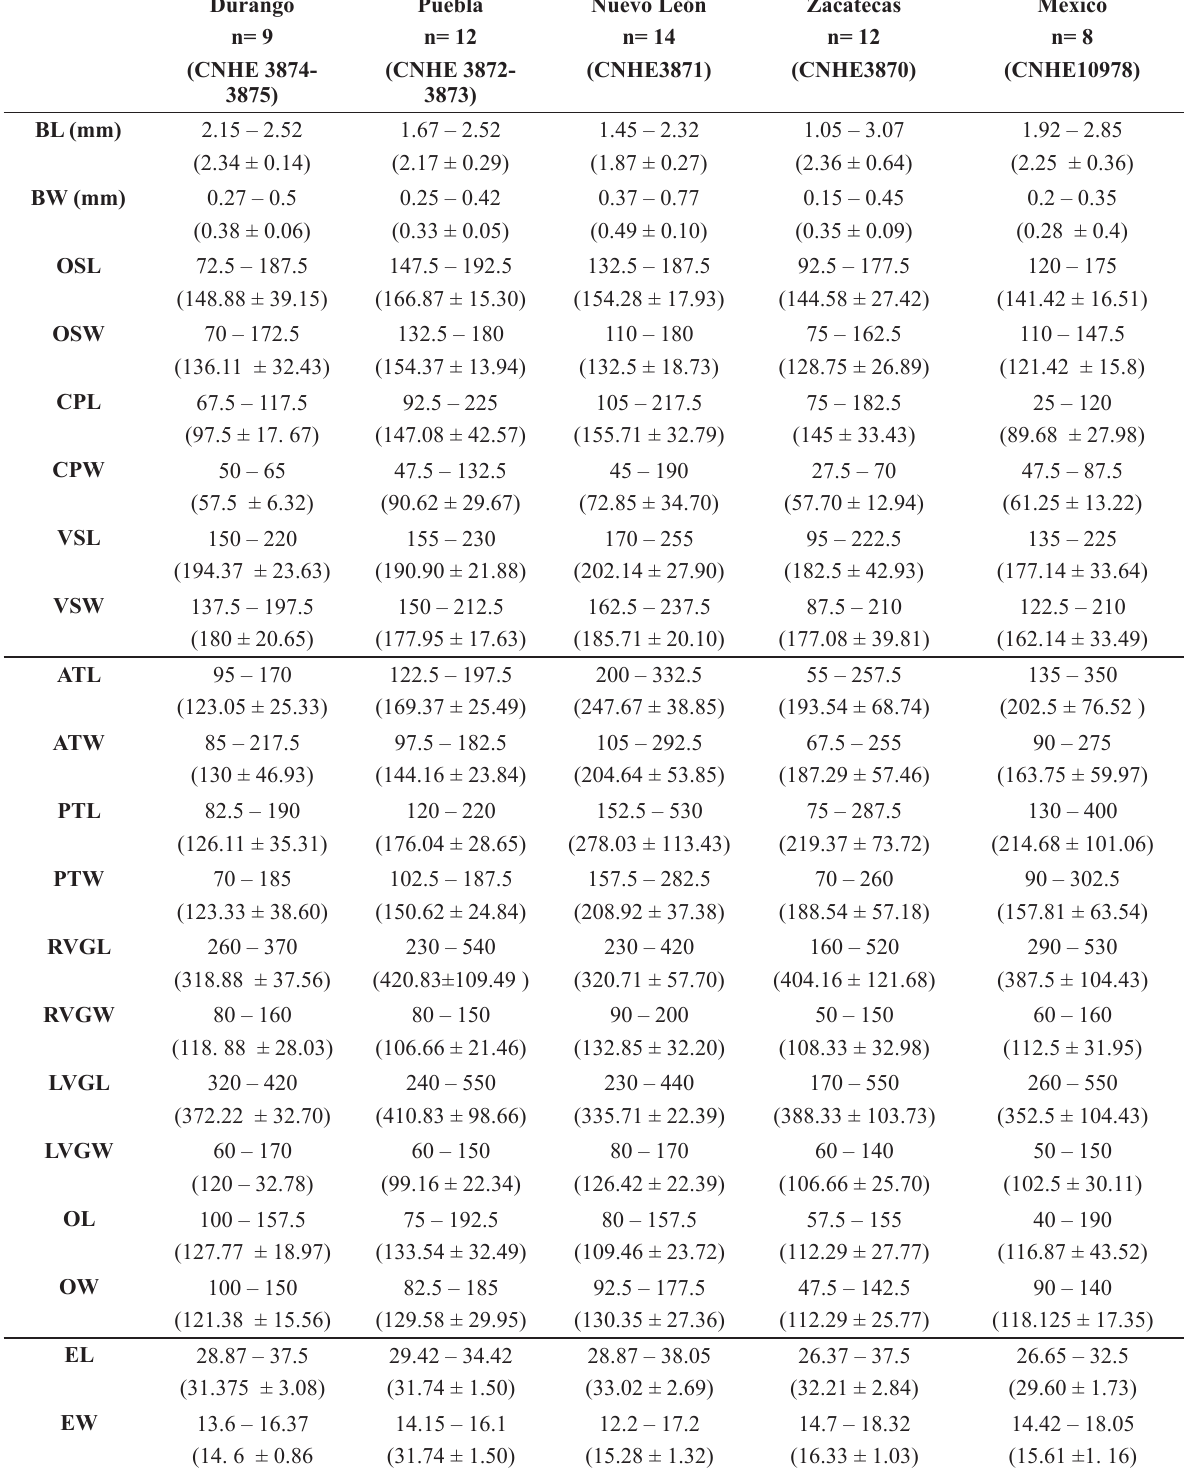
Measurements of Dicrocoelium rileyi (based on 55 specimens) of Mexico. SD: Standard deviation, mm: millimeters, n= Number of